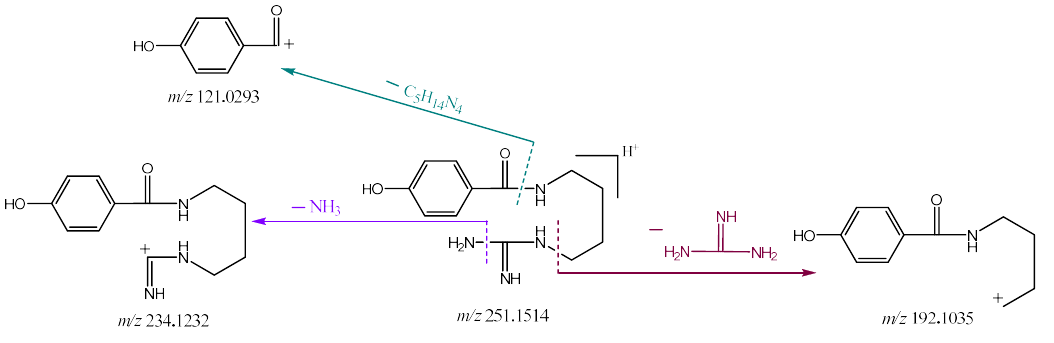
Figure 2. The proposed fragmentation pathways of compound 1 .